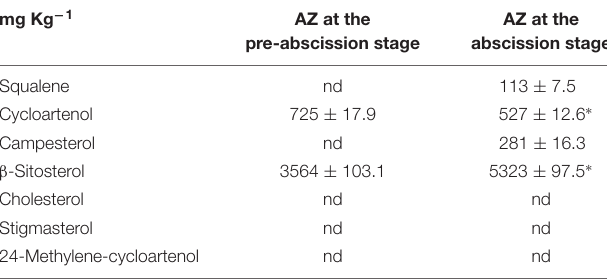
are denoted by asterisk; nd, not detectable.